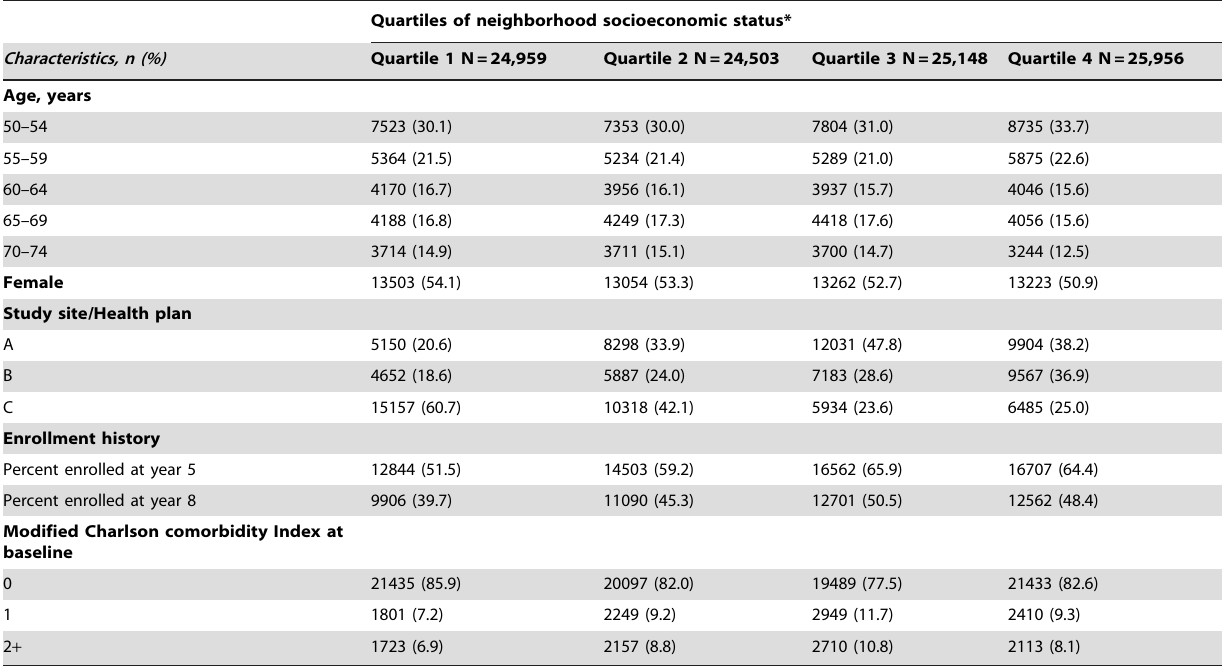
Table 1. Characteristics of the study cohort according to neighborhood socioeconomic status, N=100,566.